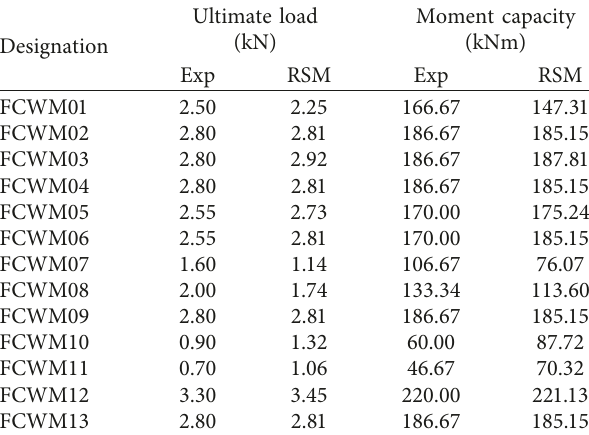
Table 3: Comparison of experimental and predicted results.